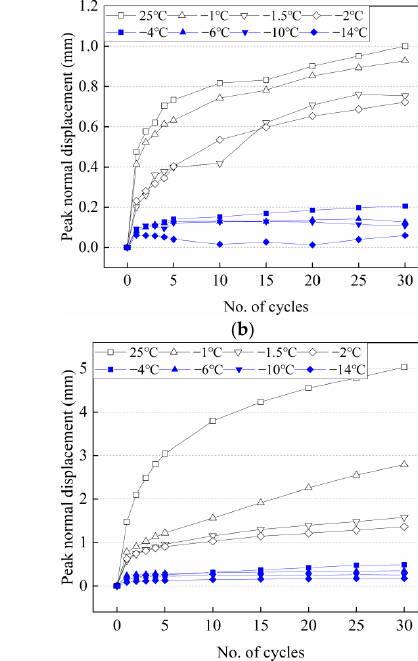
where, ν max denotes the maximum normal displacement. m and n are the parameters. As shown in Figure 15, the measured values are in good agreement with the exponential Equation (9).